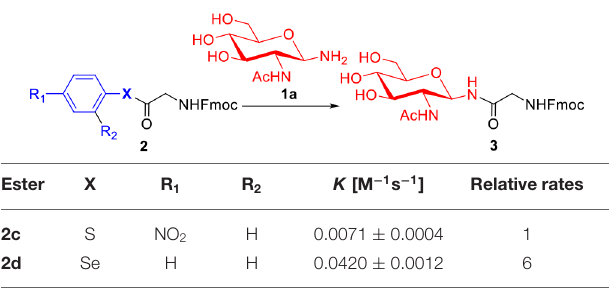
TABLE 2 | Kinetic studies for glycosidic bond formation a . TABLE 3 | Reaction optimization and control experiments a